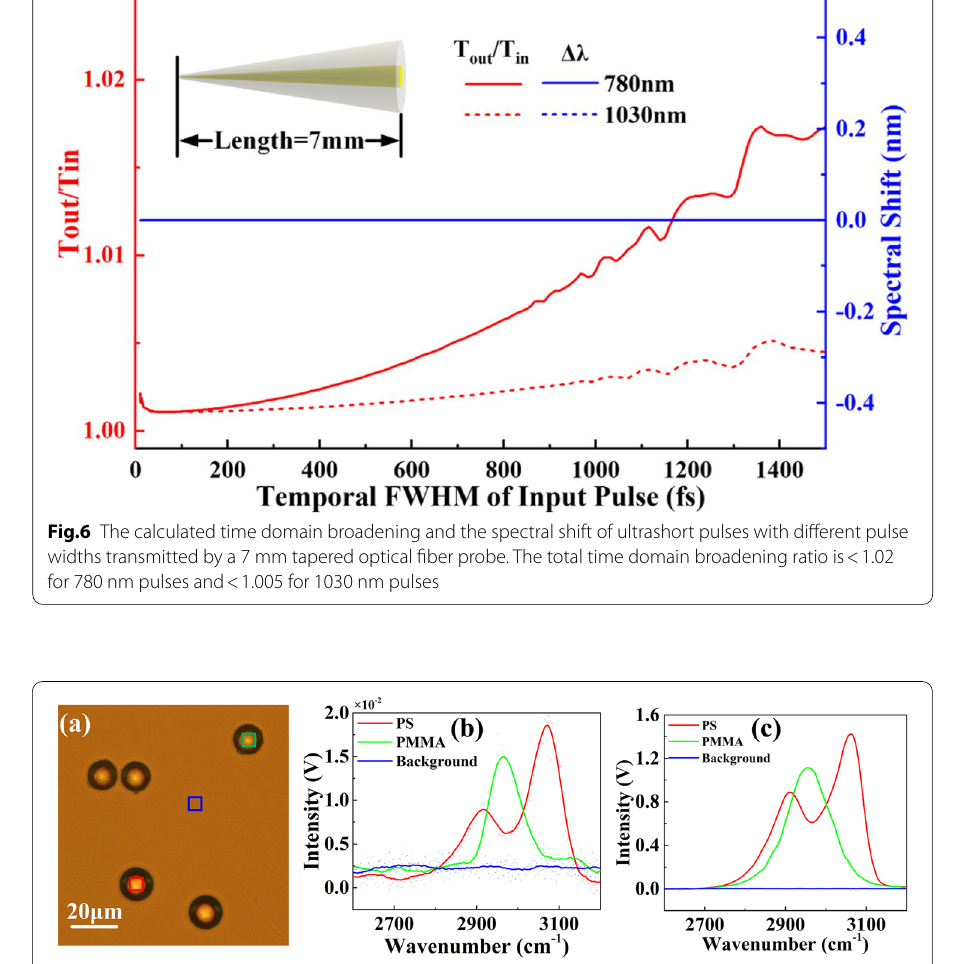
Fig.7 a Microscope image of PS microsphere and PMMA microsphere samples, the blue, red and green squares represent the slide background, PS microsphere, and PMMA microsphere, respectively. b CARS signals detected by the optical fiber probe and c free-space elements. The blue, red and green solid lines represent the signals of slide background, PS microsphere, and PMMA microsphere,